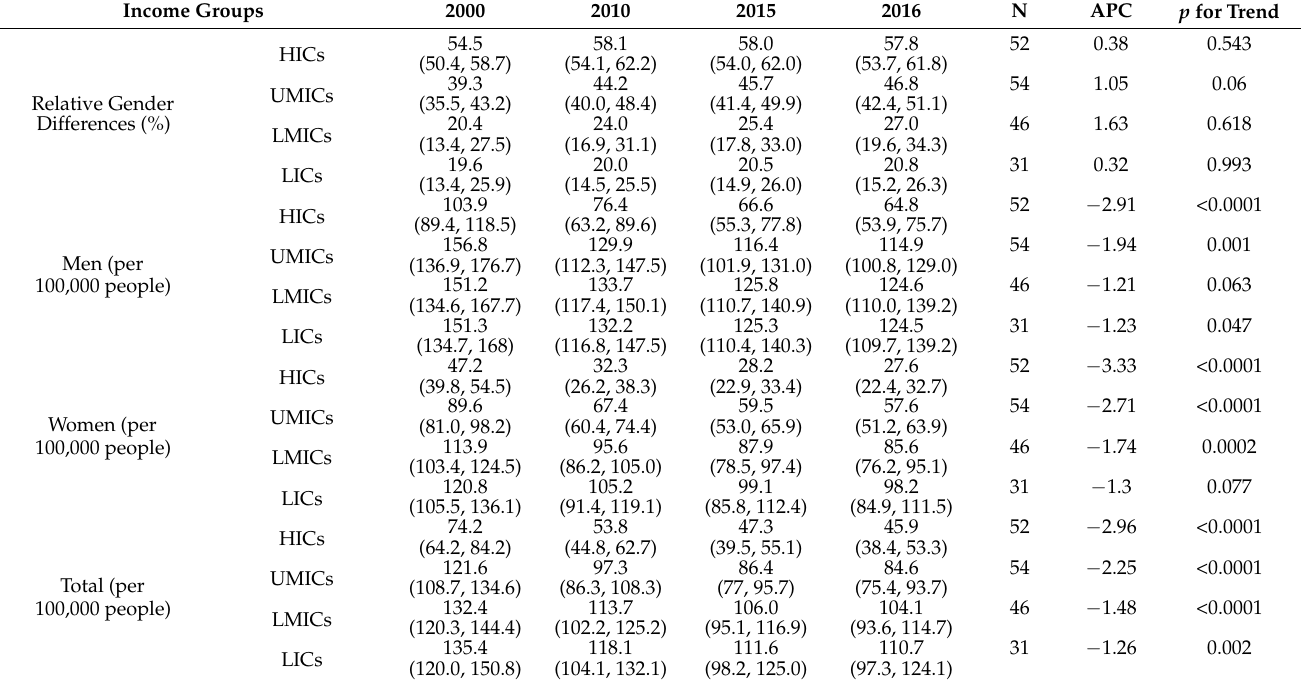
Table 2. Age-standardized premature CVD-related death rates and relative gender differences across income groups, from 2000 to 2016.